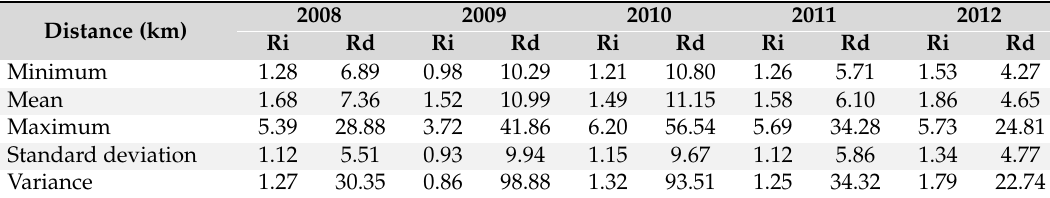
Table A5. Distance, in kilometers, of rivers (Ri) and roads (Rd) to burned scars.